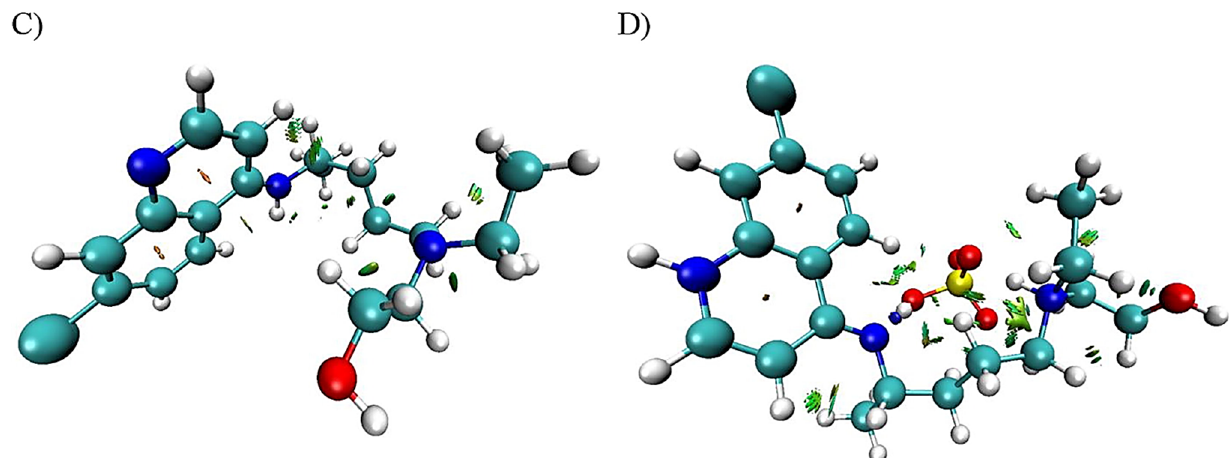
Figure 8. Graphical illustration of the reduced density gradient vs. electron density ( A , B ) and the various forms of interactions ( C , D ) of hydroxychloroquine and hydroxychloroquine sulfate compounds. Reproduced with permission from ref. [82]; Copyright 2021, Wiley.